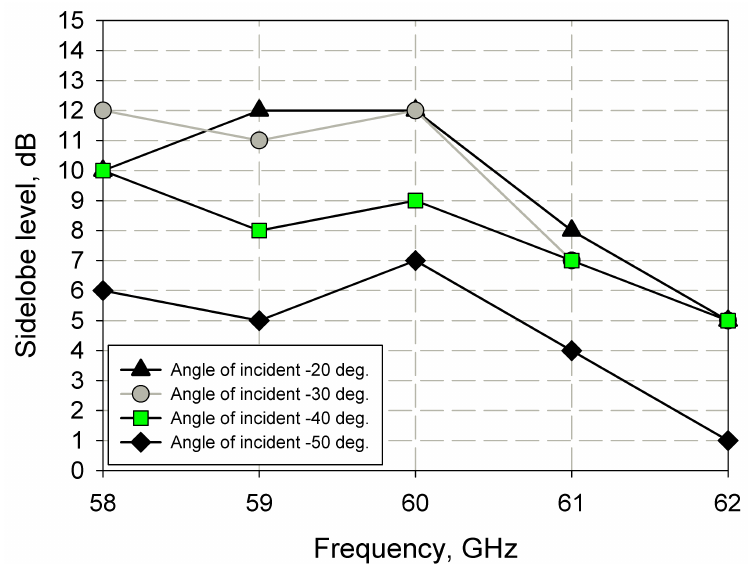
Figure 7. Simulation results of the side lobe level for different angles of the incidence in the frequency range.